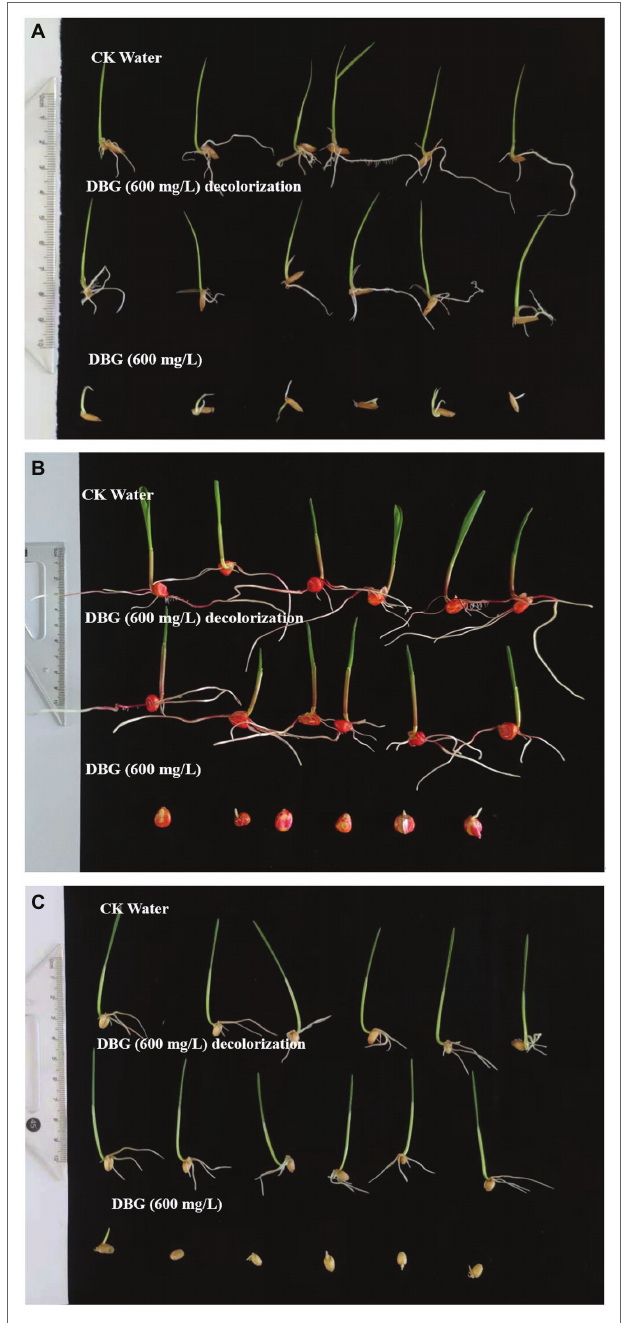
FIGURE 5 | Representative images from the biological toxicity test with (A) rice, (B) corn, and (C) wheat.